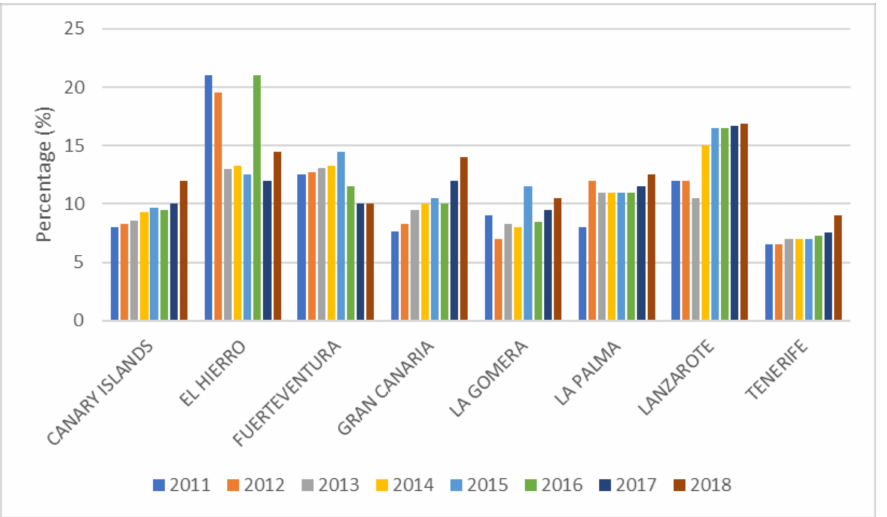
Figure 3. Sorted waste collection in the Canary Islands